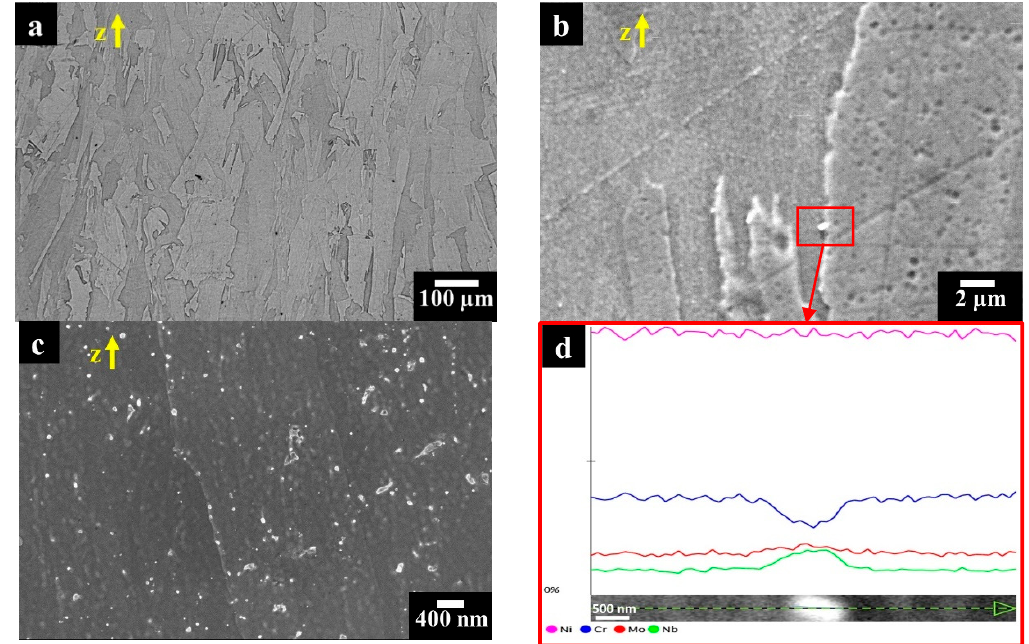
Figure 7. ( a ) Optical microscopy image of LPBF Alloy 625 annealed at 980 °C for 32 min and water quenched showing columnar grains along the building direction; ( b , c ) FESEM images of IN625 sample annealed at 980 °C for 32 min and water quenched revealing fine precipitates throughout the material, with the largest located along the grain boundaries; ( d ) EDS scan line (at higher magnification) on a carbides showing the enrichment in Nb and the depletion of Cr with respect to the austenitic matrix.